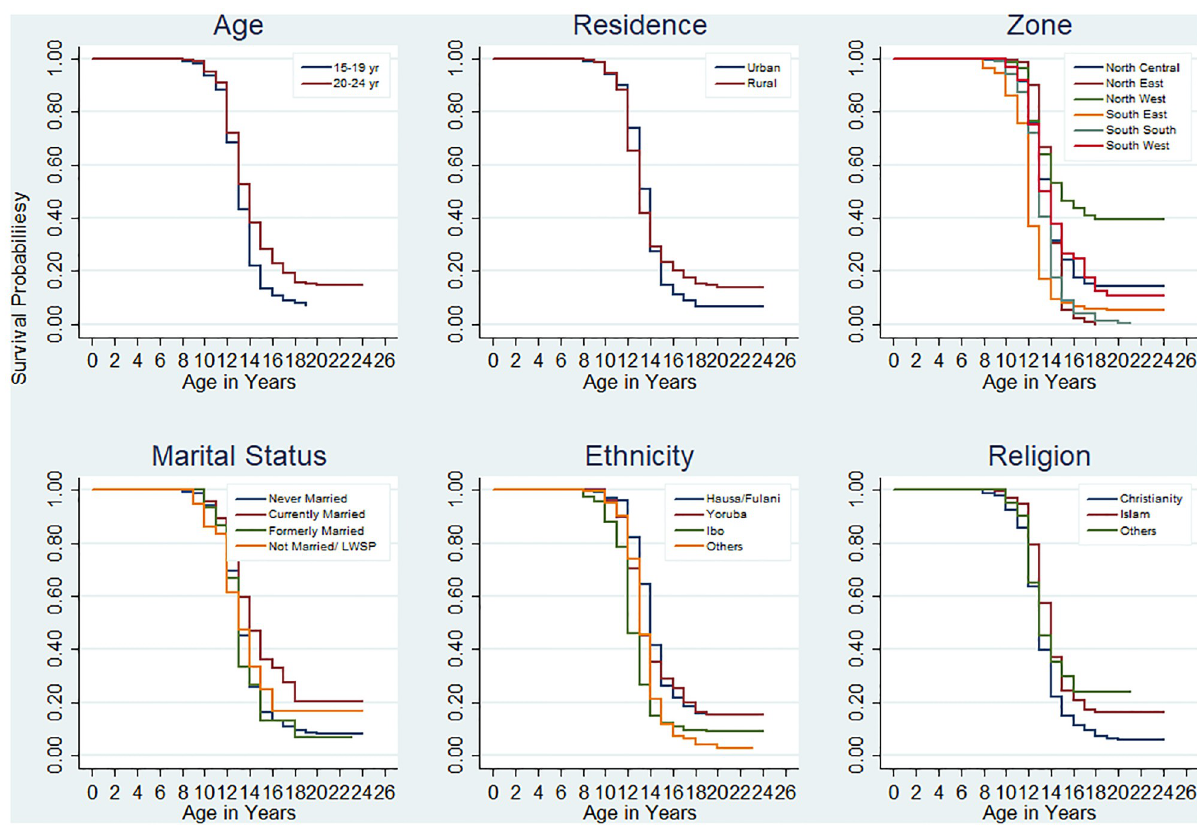
Fig 2. Survivorship curves showing probabilities of developing pubic hair at different ages by selected characteristics of males.